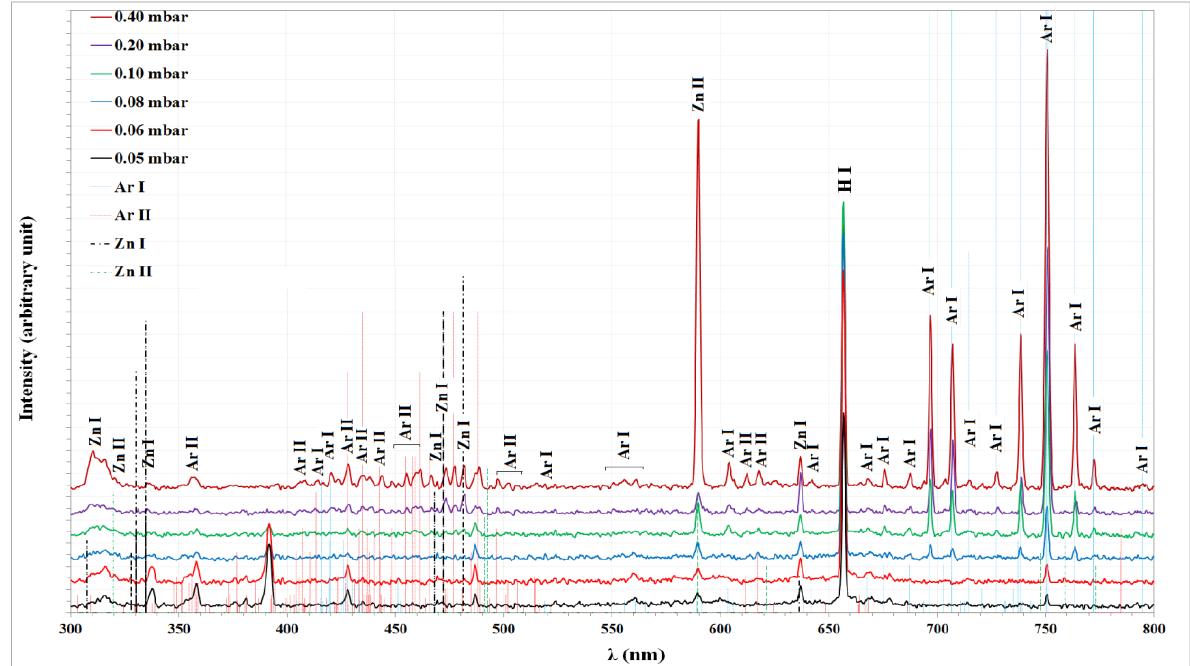
Fig. 2: Emission spectra for RF plasma in Ar with different working pressure using Zn